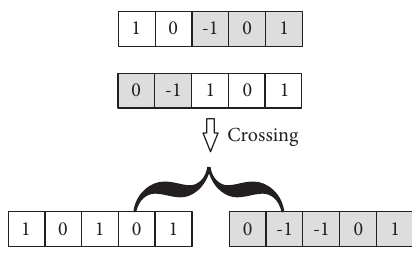
Figure 2: The basic principle of single-point